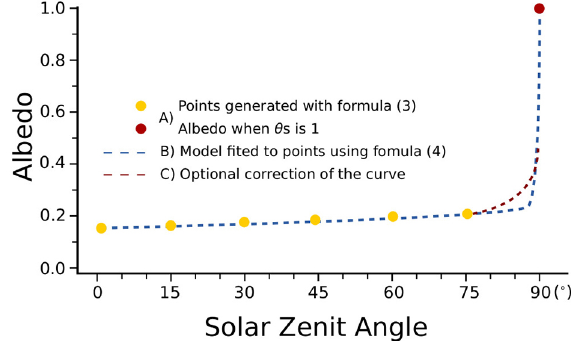
Fig. 2. The model fitting procedure. (A) Point data generated from Eq. (3); (B) fitting Eq. (4) to points; (C) model